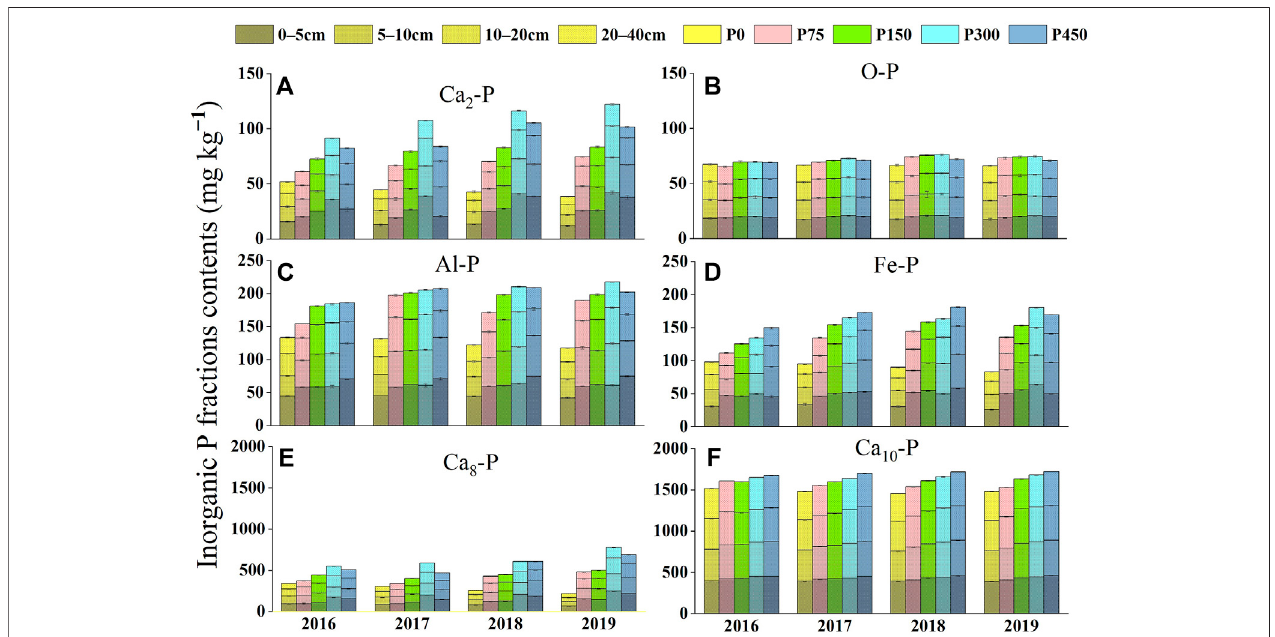
FIGURE 1 | Inorganic P fractions (A) Ca 2 -P, (B) O-P, (C) Al-P, (D) Fe-P, (E) Ca 8 -P, and (F) Ca 10 -P contents in different treatments in 2016 – 2019.